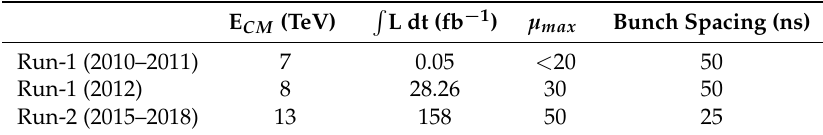
Table 1. The Large Hadron Collider (LHC) parameters most relevant for operations of the luminosity Cerenkov integrating detector (LUCID) in Run-1 and Run-2. L refers to the instantaneous delivered luminosity in pp collisions, and µ max to the typical pileup at the beginning of each run. More details can be found in References